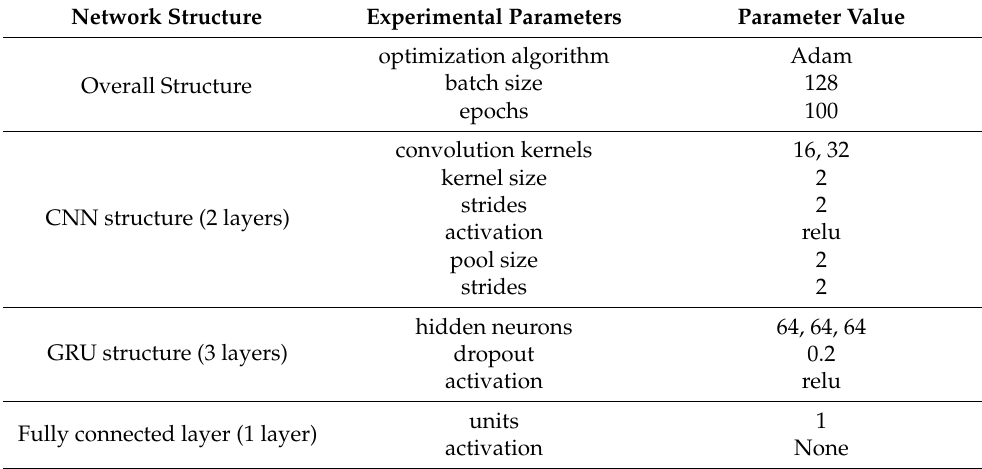
Table 1. CNN-GRU model parameter